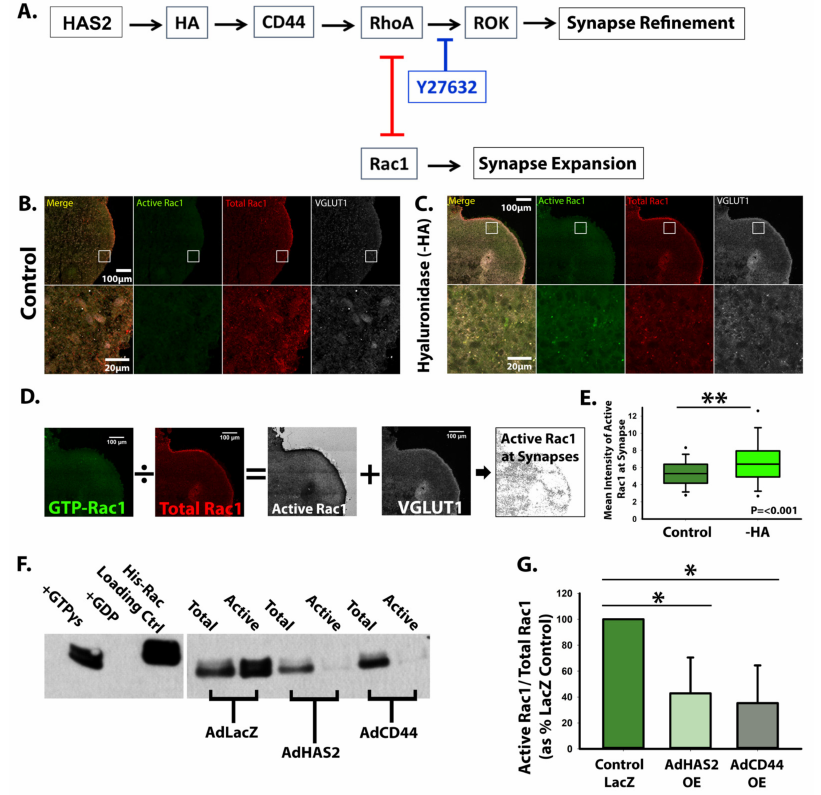
Figure 9. HAS2, HA, and CD44 regulate synapse formation via RhoGTPase signaling. ( A ) Graphic representation of proposed mechanism by which HAS2, HA, and CD44 regulate the antagonistic relationship between RhoGTPases, RhoA and Rac1, to promote refinement of excitatory synapses. ( B , C ) Control cortical spheroids ( B ) or cortical spheroids treated with streptomyces hyaluronidase ( C ) to degrade HA were immunostained for active GTP-bound Rac1 and total Rac1 together with VGLUT1 to visualize association with developing excitatory synapses. ( D ) Ratiometric imaging was performed by dividing the fluorescence intensity for GTP-Rac1 by the fluorescence intensity for total Rac1. The resulting ratiometric image intensity was measured in particles corresponding to VGLUT1 area. ( E ) Quantification of Rac1 activity associated with VGLUT1-postive compartments reveals that HA suppresses Rac1 activity, while treatment with hyaluronidase significantly increases Rac1 activity. n = 9 total spheroids for each treatment derived from 3 separately grown and treated spheroid sets. ** p < 0.001 ( F ) Immunoblot of Active Rac1 pulldown. Glutathione affinity beads were used to pulldown GTP-Rac1. Columns left to right: +GTP γ s positive control, +GDP negative control, His-Rac1 antibody loading control, Total (30 µ g) and Active (300 µ g of lysate incubated with beads) samples for spheroids transduced with AdZsGreenLacZ, AdZsGreenHAS2, or AdZsGreenCD44. ( G ) Quantification of Active Rac1 pulldowns reveal HAS2 and CD44 overexpression decrease Rac1 activity, reported as GTP γ s-Rac1/Total-Rac1 as percent of AdZsGreenLacZ control. n = 3 spheroids for each AdZsGrnLacZ, AdZsGrnHAS2 and AdZsGrnCD44 derived from 3 separately grown and transduced spheroid sets, ran on 3 separate western blot analyses. * p <